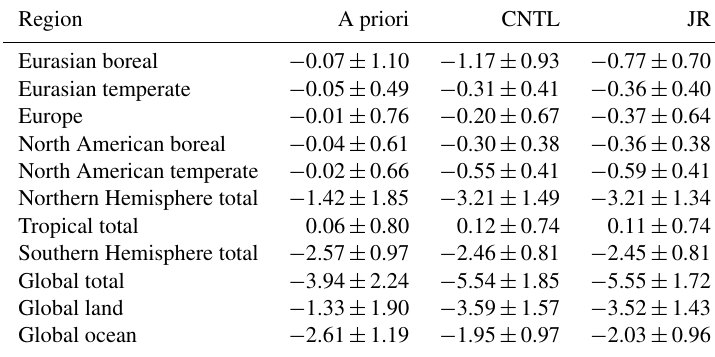
Table 2. A priori and optimized surface CO 2 fluxes and their 1 σ uncertainties (PgCyr − 1 region − 1 ) of global total, land, ocean, and other regions averaged spatially from 2002 to 2009. The CNTL experiment is conducted by using a set of observations without observations in the Siberia region, whereas the JR experiment is conducted using all available observations including the Siberia data. Region A priori